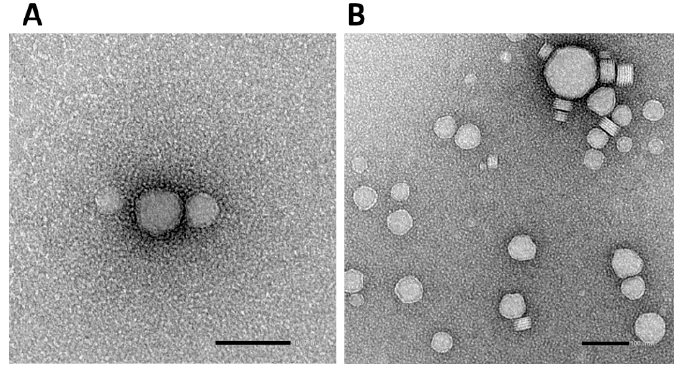
Figure 2. TEM images of GPxT-CQ cationic niosome. Scale bar: 100 nm. ( A ) 80,000× magnification; ( B ) 50,000× magnification. ( B ) 50,000 ×